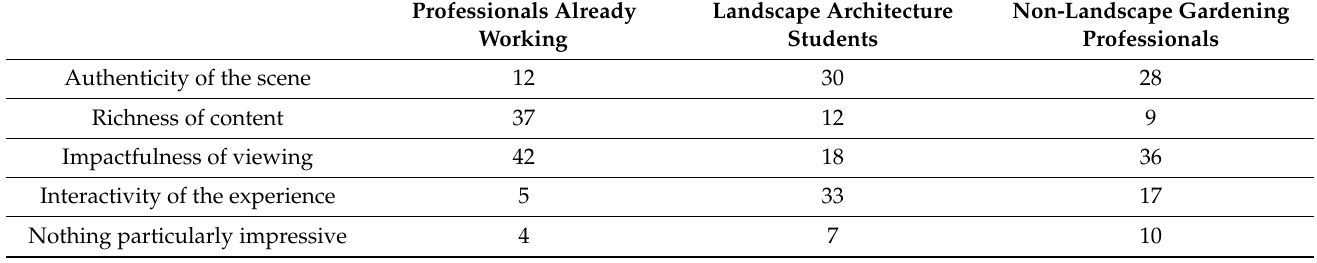
Table 4. Analysis of attraction points of MID expressions based on computer vision (%).